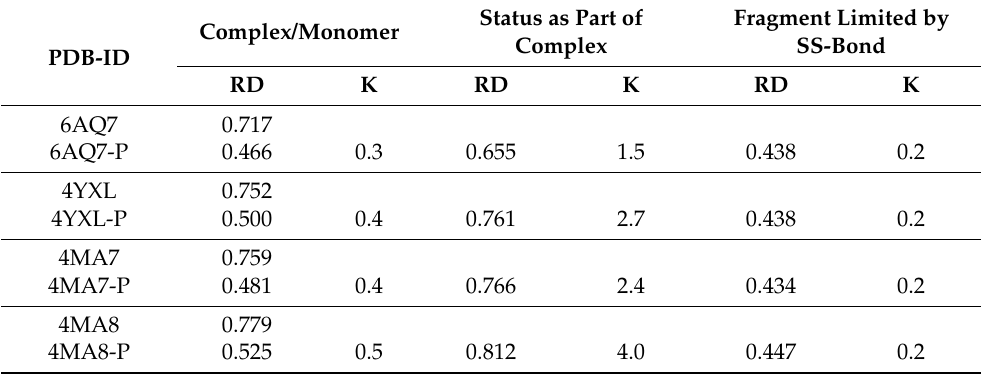
Table 5. Prion molecules in complex with fragment Fab of IgG–PDB-ID, with P added to the PDB ID denoting prion chain treated as an individual chain.